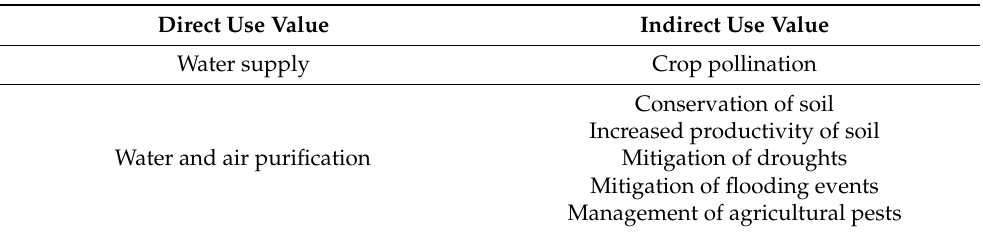
Table 2. Services provided by biodiversity that people in Africa are directly and indirectly depending on (adapted from